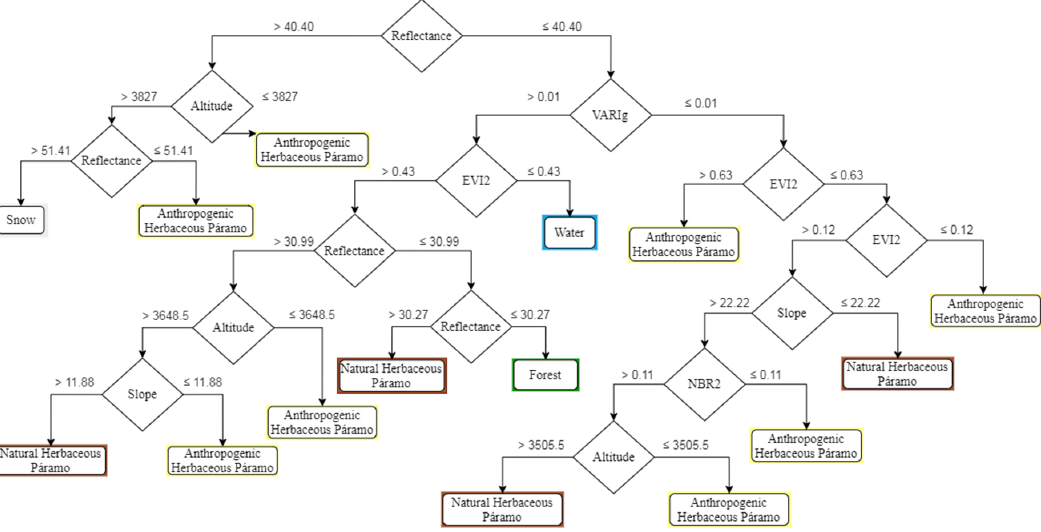
Figure 4. The classifier decision tree.